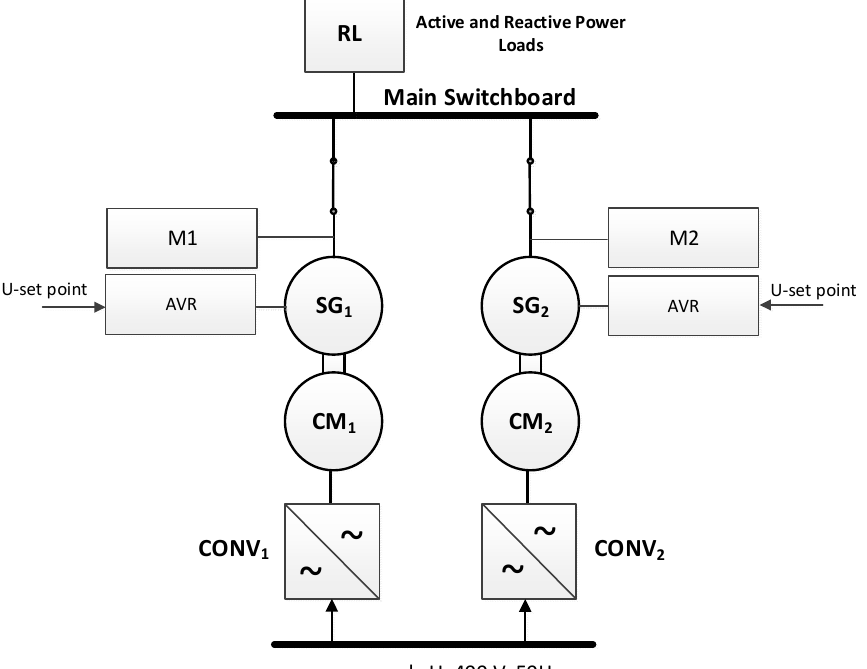
Figure 14. Schematic diagram of the laboratory stand. Figures 15 and 16 present the view of the laboratory stand.